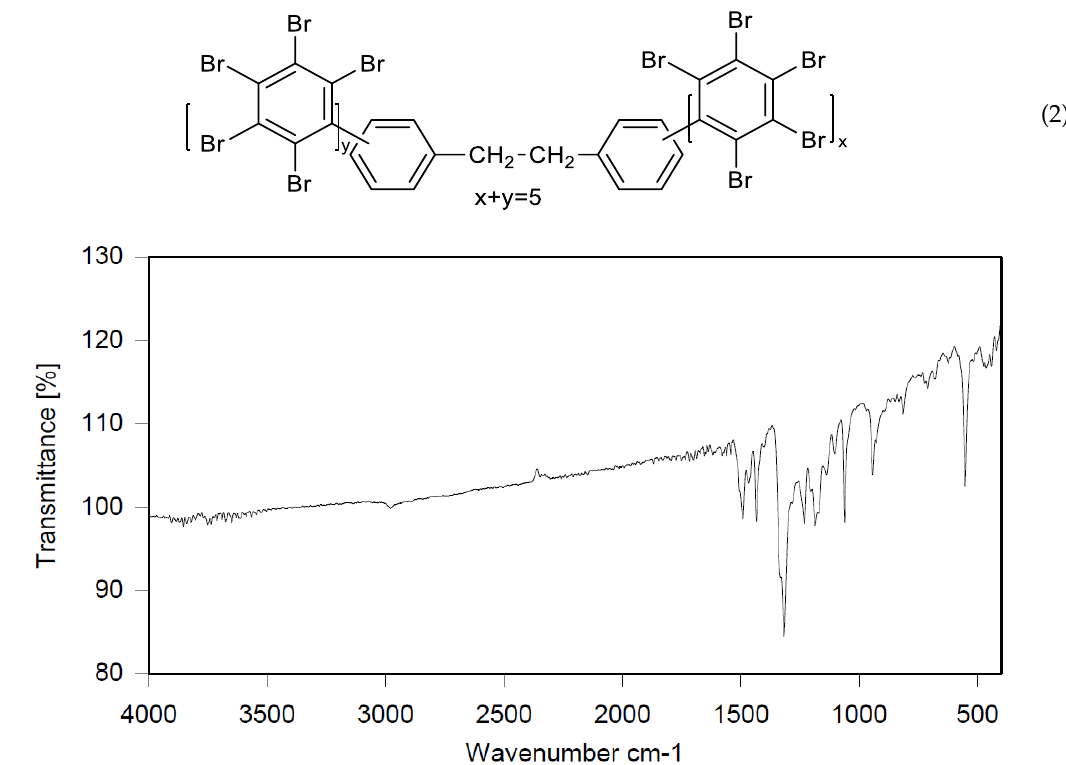
Figure 2. FTIR spectrum of diphenylethane alkylated with PBBB (DPE-PBBB).